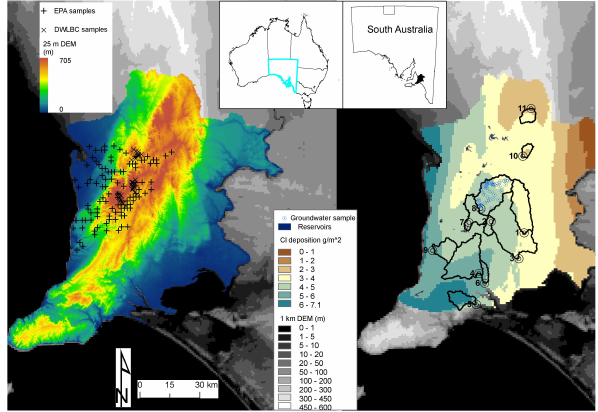
Fig. 3. The study area, left-hand side: digital elevation map showing the Mount Lofty Ranges (MLR), with stream water samples used to derive the relationship between chloride concentration and EC measurements (data from DWLBC and EPA), and right-hand side: eleven catchments of the MLR (the numbers correspond to those in Table 2), overlying the annual chloride deposition map with ground- water sample locations of chloride concentration for CMB applica- tion. Note that catchment 7 includes catchment 8, and catchment 3 includes catchment 1. The river to the east of MLR, flowing to the south, is the Murray River, which provides about 50% of water for the Adelaide metropolitan area via three main pipe lines through MLR (not shown). The inserts of Australia and South Australia maps are included to show regional location of the study area.